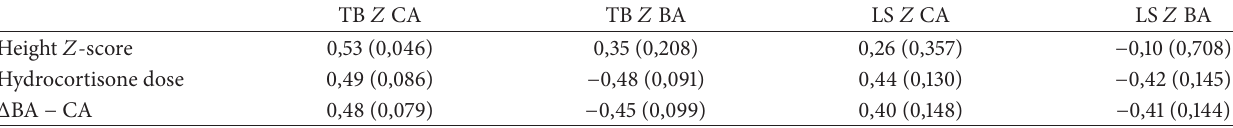
Table 4: Pearson correlation between height 𝑍 -score, hydrocortisone dose and BA less CA, and BMD 𝑍 -scores with 𝑃 value.